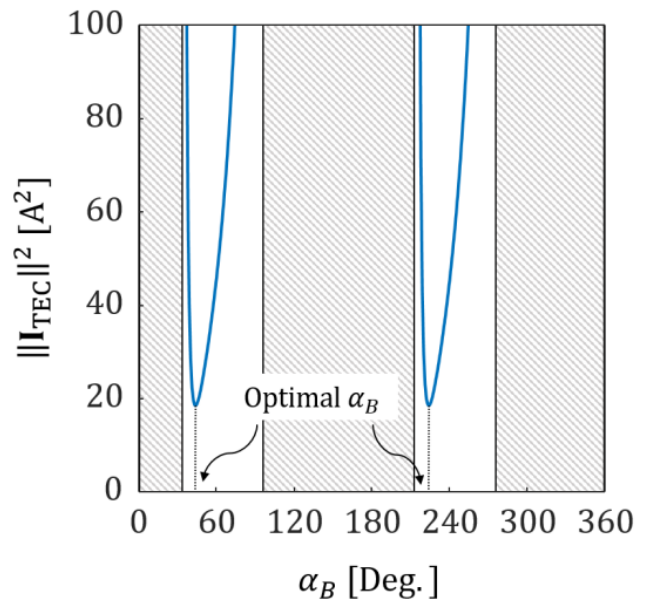
Figure 6. The variation in the TEC’s overall currents with respect to the aligning direction of the microrobot required to generate the magnetic force shown in Figure 5.